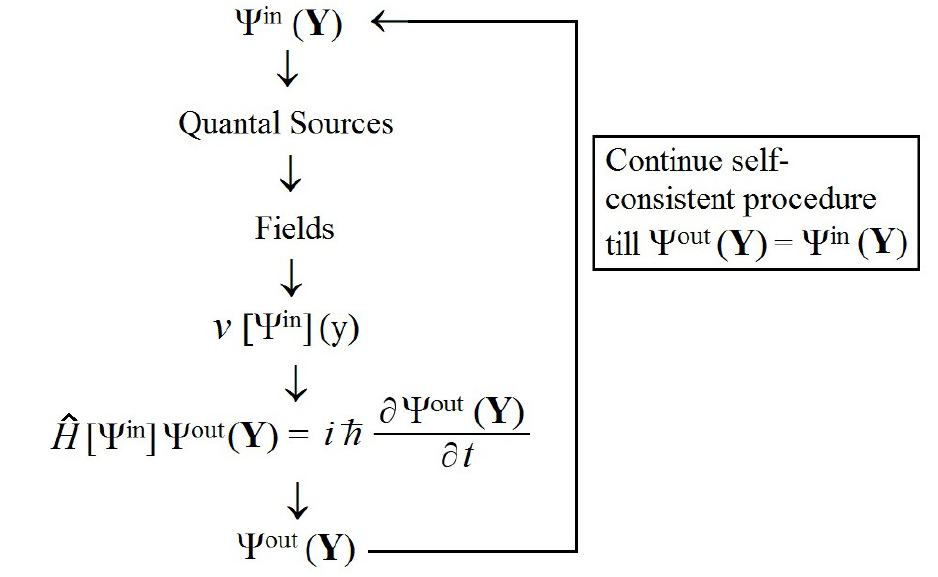
Figure 1. Procedure for the self-consistent solution of the Schrödinger equation at each instant of